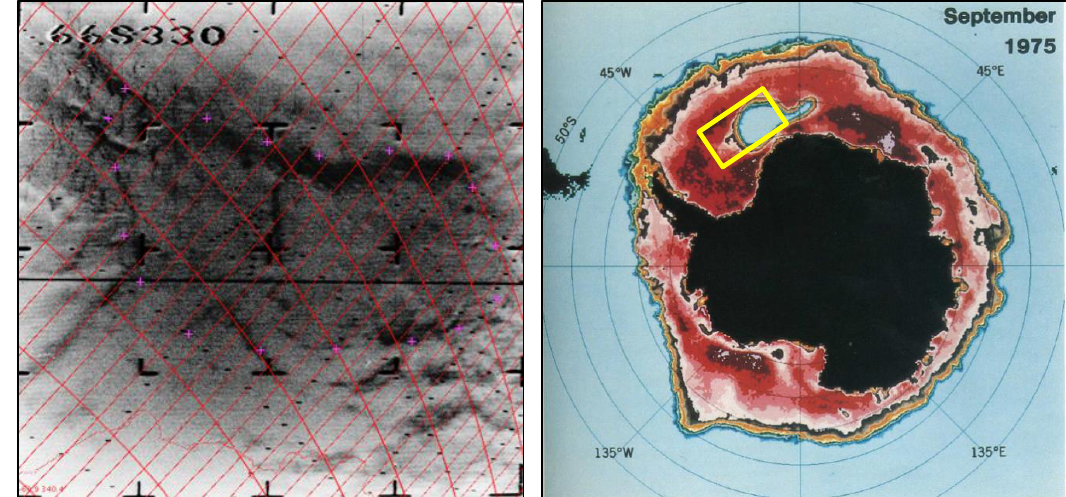
Fig. 5. Nimbus I image from the region of the Weddell Sea polynya (66 ◦ S, 330 ◦ E) in September 1964 (left), and the polynya seen in sea ice concentrations derived from passive microwave imagery in September 1975 (right); the yellow square indicates the approximate location of the 1964 scene, which covers an area of roughly 500 × 2000km. The dark features in the Nimbus I image indicate potential low ice concentration, and the darkest areas appear to be open water. However, it is not clear if there was a polynya at or near the time of the image or just an indication of leads and